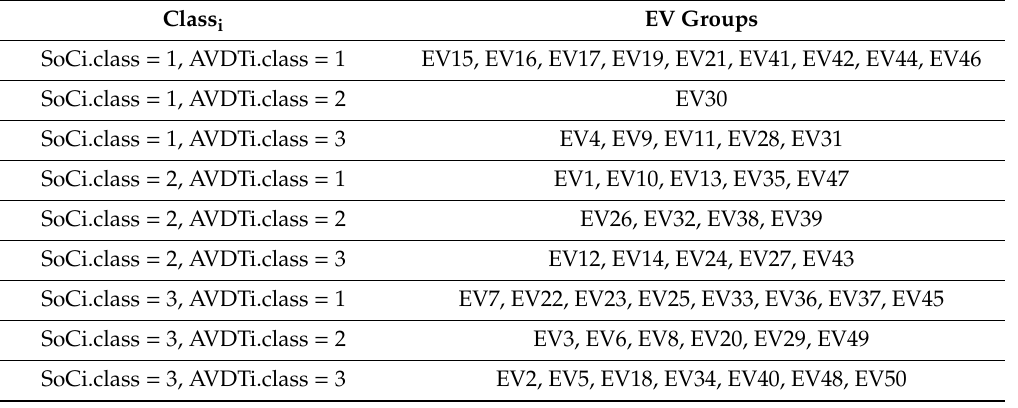
Table 2. Reorganized EV Groups.